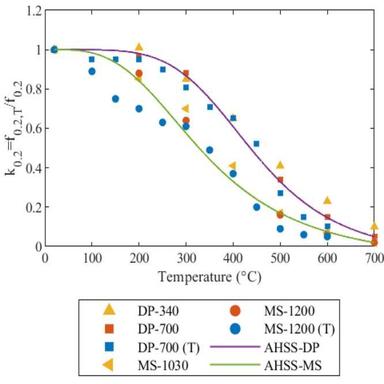
Comparison of proposed retention factors for 0.2% proof stress with test data.